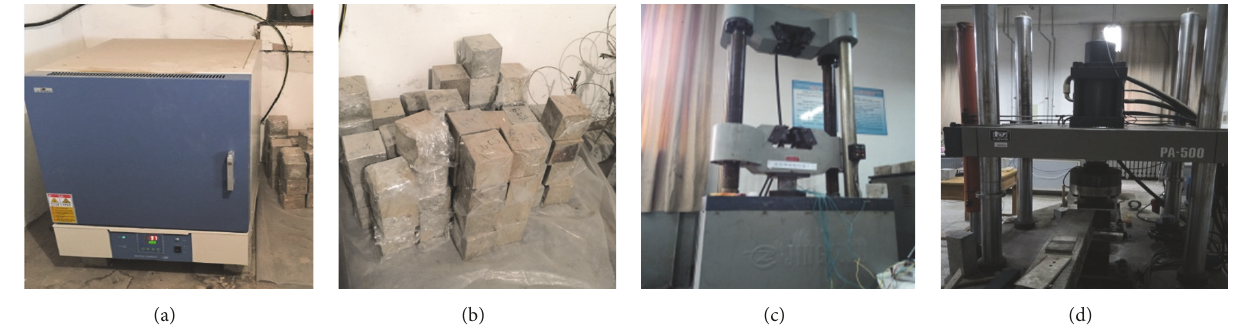
Figure 1: Apparatus and specimens: (a) box-type resistance furnace; (b) specimens; (c) electrohydraulic servo pressure machine; (d) electro- hydraulic servo fatigue machine.